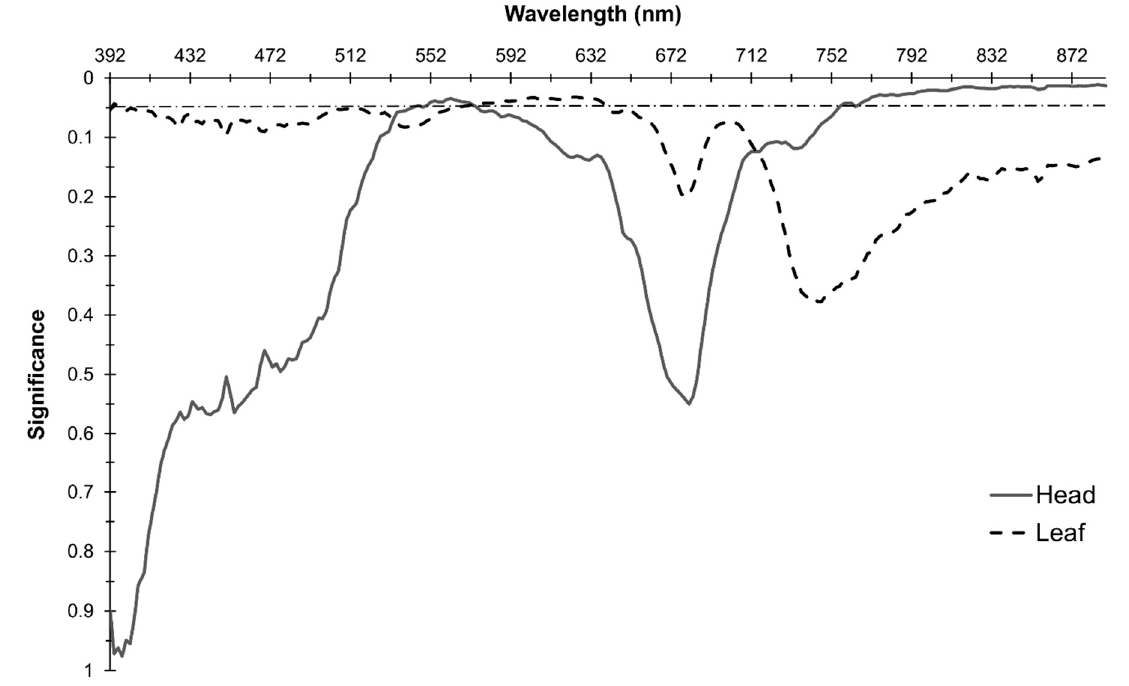
Figure 4. Probabilities corresponding to the interaction of the frost treatment and DAF on the spectral response. Horizontal dashed line is at p = 0.05.